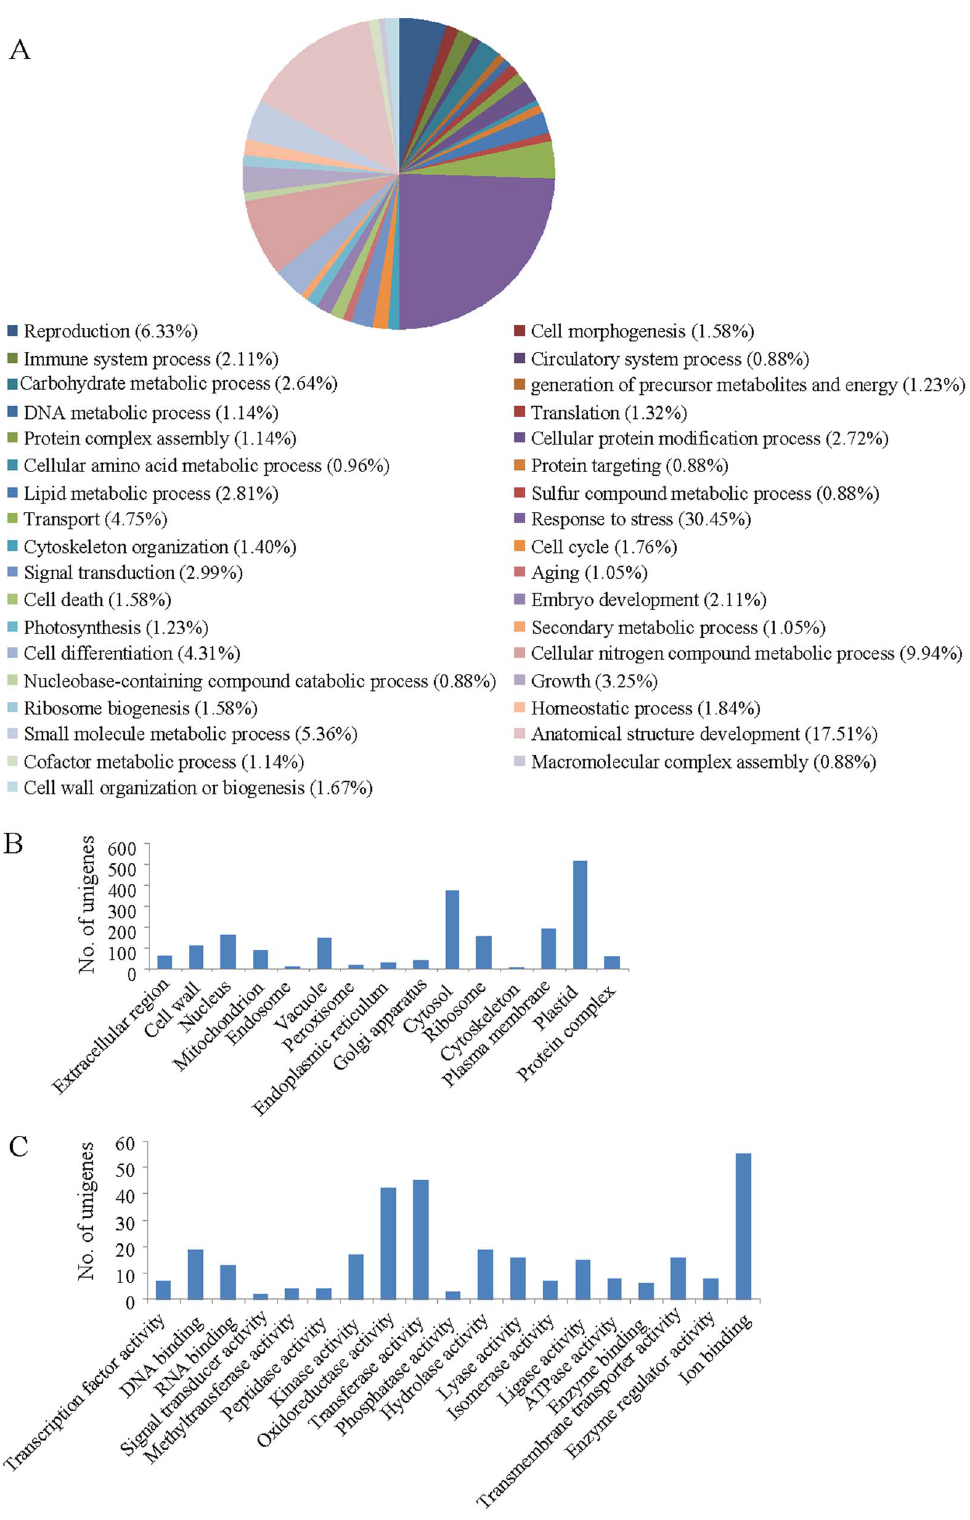
Figure 4. Functional categorization of geraniol-responsive transcripts based on Gene Ontology (GO) biological process (A), cellular component (B) and molecular function (C). doi:10.1371/journal.pone.0076029.g004 like protein , ethylene response factors ( ERFs ) were identified to be geraniol-responsive (Table S2). Hence, geraniol-responsive ex-